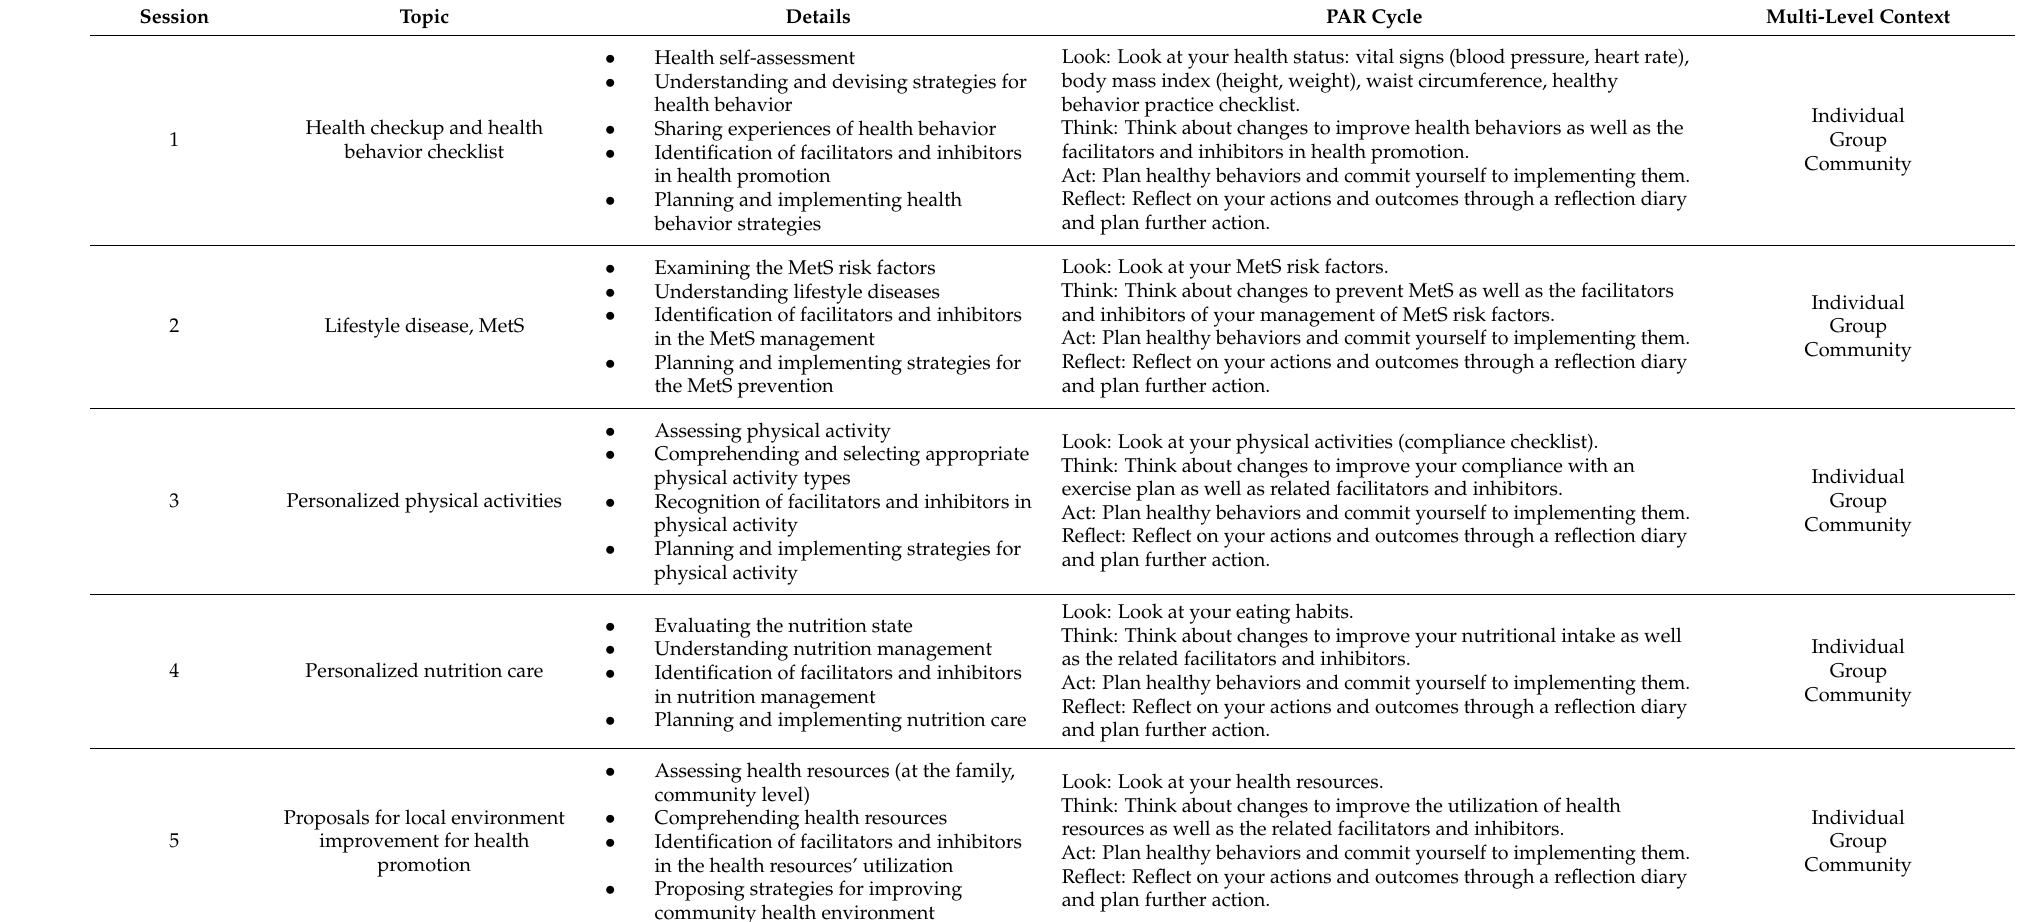
Table 1. Contents of the PAR